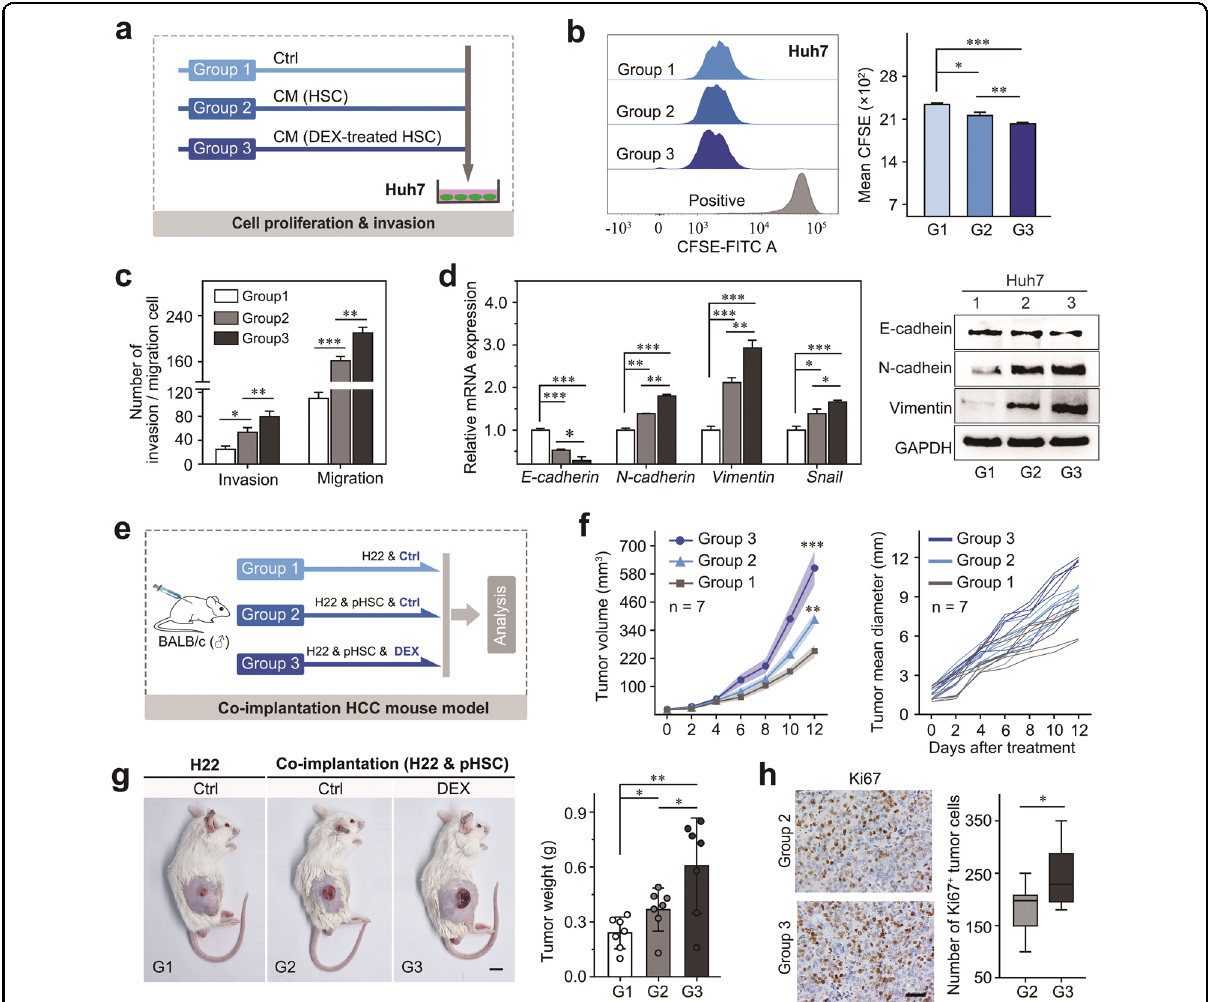
Fig. 5 DEX promoted the proliferation and metastasis of HCC in the presence of aHSCs. a Experimental design for investigating the effects of DEX on HCC cell proliferation and metastasis in the presence of HSCs. b The effect of DEX (10 μ M)-pretreated HSC CM on Huh7 cell proliferation indicated by CFSE assay. c The invasion/migration ability of Huh7 cells in the presence of DEX-pretreated HSC CM. d The mRNA level (left panel) and protein level (right panel) of the indicated EMT-related biomarkers in Huh7 cells treated with DEX were investigated by RT-PCR and western blotting. e Experimental design to investigate the effects of DEX on HCC growth in H22 (mouse HCC cells) and primary HSC coimplantation models. f Measurement of the tumor volume [(length × width 2 )/2] (left panel) and tumor mean diameter (right panel) in H22 and primary HSC coimplantation mice that were treated with vehicle or DEX (10 μ g/kg); data are presented as the mean ± SEM. g Representative image of a mouse from the indicated group (left panel) and statistical analysis of tumor weight at the end point (right panel). h Representative image of Ki67 IHC of mouse HCC tissue (left panel) and statistical analysis of Ki67 IHC results (right panel) are shown. Data are presented as the mean ± SD. * P < 0.05; ** P <